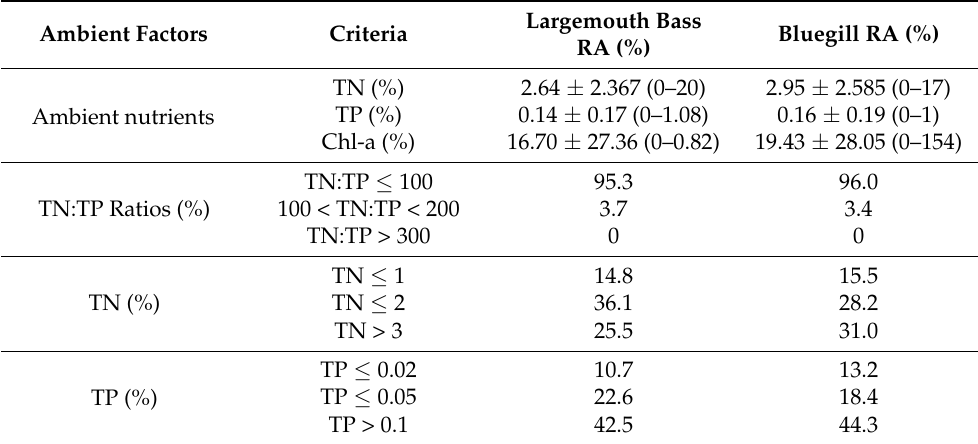
Table 3. Relationship between the relative abundance (RA %) of largemouth bass and bluegill populations, ambient Chl-a, TN, TP, and their ratios. Largemouth Bass Bluegill RA (%) Ambient Factors Criteria RA (%) TN Ambient nutrients